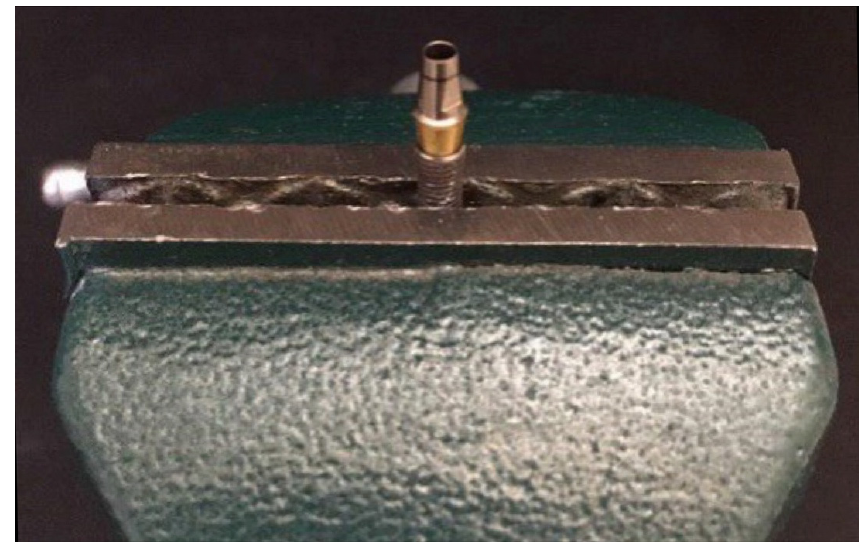
Figure 2. Placement of the abutment–implant assembly into the fixation